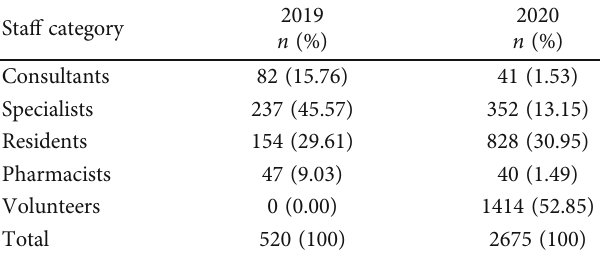
Figure 1: Number of COVID-19 consultations received by the 937-Call Center during 2020 compared to total calls received during 2019 (March-September). Table 2: Change in the total number of sta ff and volunteers working in the 937-Call Center in 2019 and 2020 between March and